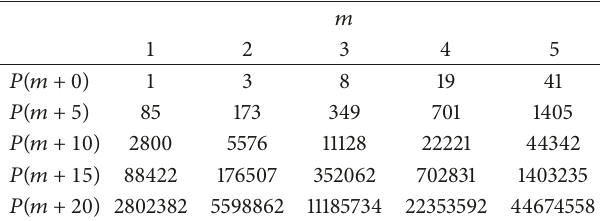
Table 3: The values of 𝑃(𝑛) sequence: these points will be used as start points of generations in order to compute statistical quantities of 𝑄 𝑏 (𝑛) .